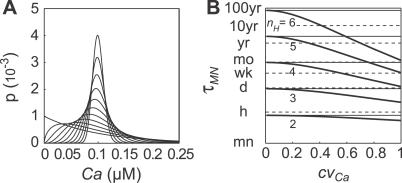
Robustness to Basal Calcium Variability(A) Calcium fluctuations modeled as gamma distributions with mean Ca
0 = 0.1 μM and standard deviations corresponding to coefficient of variation, cvCa, in the range 0.01–1.(B) Memory time constant in the absence (thin lines) and presence (thick lines) of calcium fluctuations with gamma distribution, as a function of the coefficient of variation of calcium fluctuations, cvCa, for different values of nH.